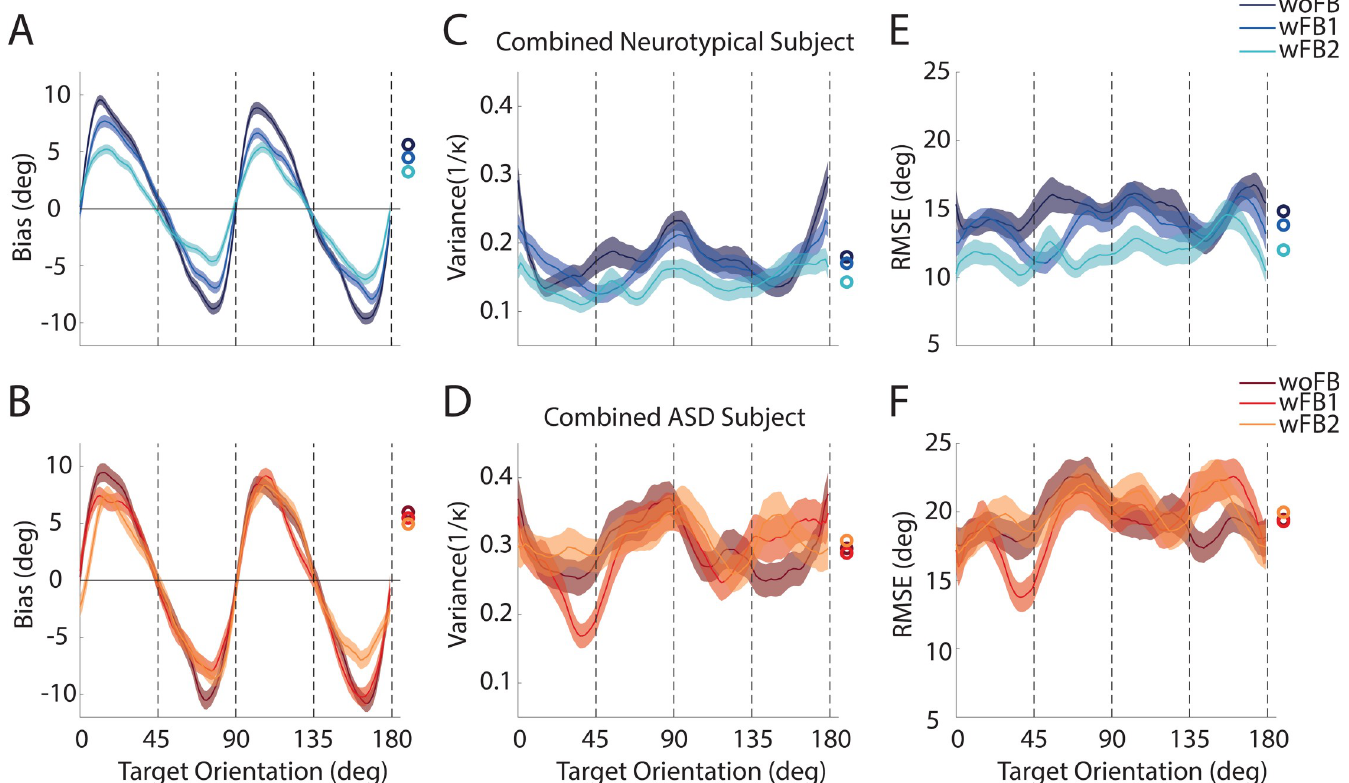
Fig 3. Orientation perception in combined neurotypical and ASD participant. Bias (y-axis) as a function of target orientation (x-axis, cardinal and oblique orientation indicated by dashed lines) and feedback block in neurotypical (A ) and ASD (B) participants. Variance (1/ κ , y-axis, see Materials and methods) as a function of target orientation and feedback block in neurotypical (C) and ASD (D) participants. RMSE (y-axis) as a function of target orientation and feedback block in neurotypical (E) and ASD (F) participants. Smoothing using a sliding window of 18˚ has been applied for visualization purpose. Error bars are ± SEM across 5,000 bootstrap runs. Raw data and code underlying this figure can be found at S1 Code , and numerical values that make up this figure can be found at S3 Data . ASD, autism spectrum disorder; RMSE, root-mean-square error.